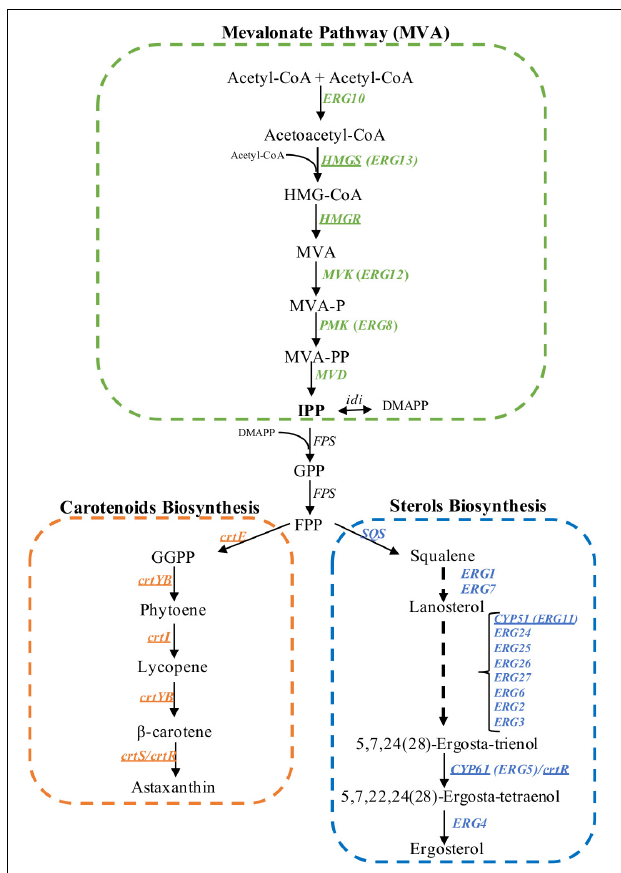
FIGURE 1 | Biosynthesis of isoprenoids in X. dendrorhous. Mevalonate pathway (in green), astaxanthin (in orange) and ergosterol biosynthesis (in blue). The arrows represent catalytic steps and the respective enzyme encoding gene. Underline genes have been functionally characterized in X. dendrorhous . The ergosterol biosynthesis pathway was abbreviated based on the pathway described in S. cerevisiae. HMG-CoA, 3-hydroxy-3-methylglutaryl-CoA; MVA, mevalonate; MVA-P, mevalonate-5-phosphate; MVA-PP, mevalonate-5-pyrophosphate; IPP, isopentenyl-pyrophosphate; DMAPP, dimethylallyl-pyrophosphate; GPP, geranyl-pyrophosphate; FPP, farnesyl-pyrophosphate; GGPP, geranylgeranyl-pyrophosphate. Figure adapted from Loto et al.